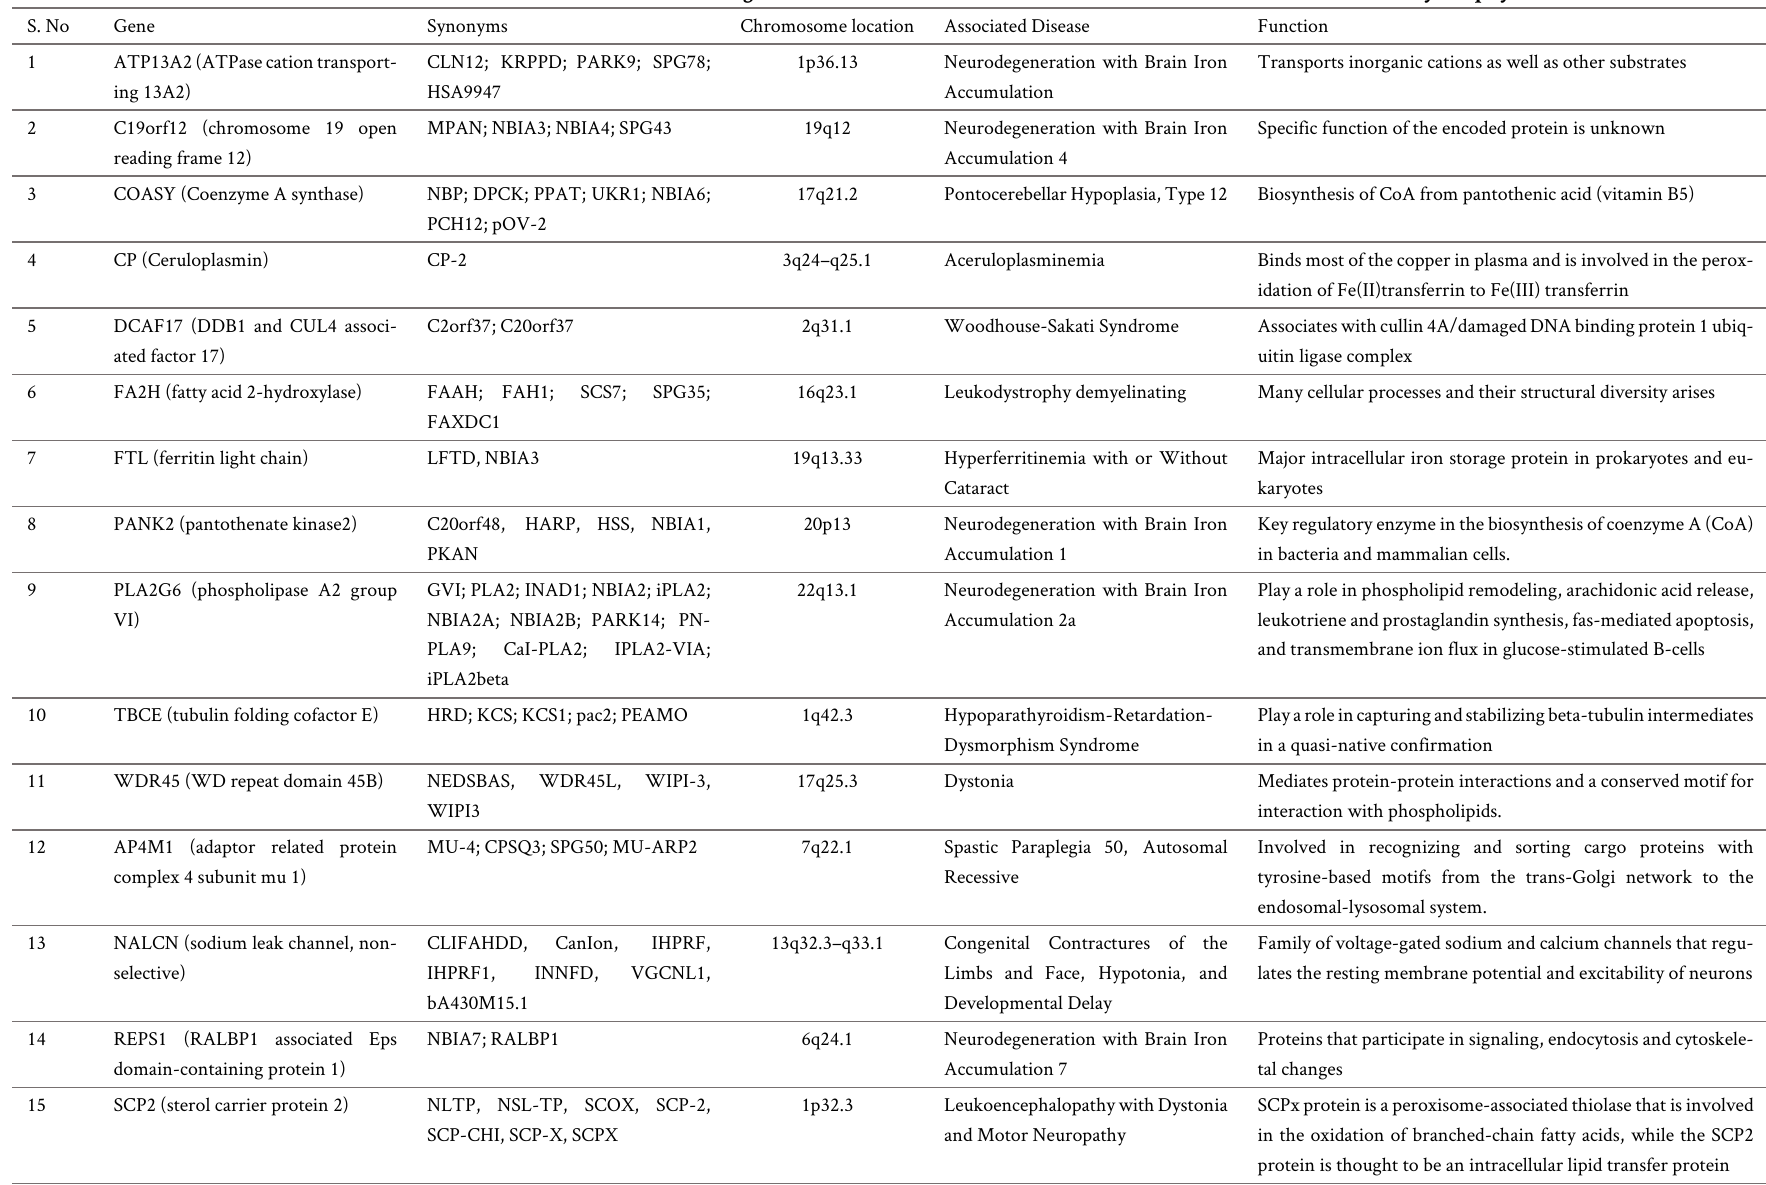
Table 3. Gene information is associated with neurodegeneration with brain iron accumulation and infantile neuroaxonal